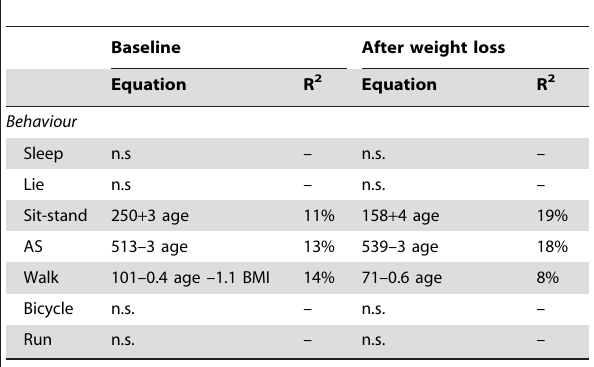
Table 2. Relationship between the daily duration of different types of activities and subjects’ characteristics at baseline and after weight loss.